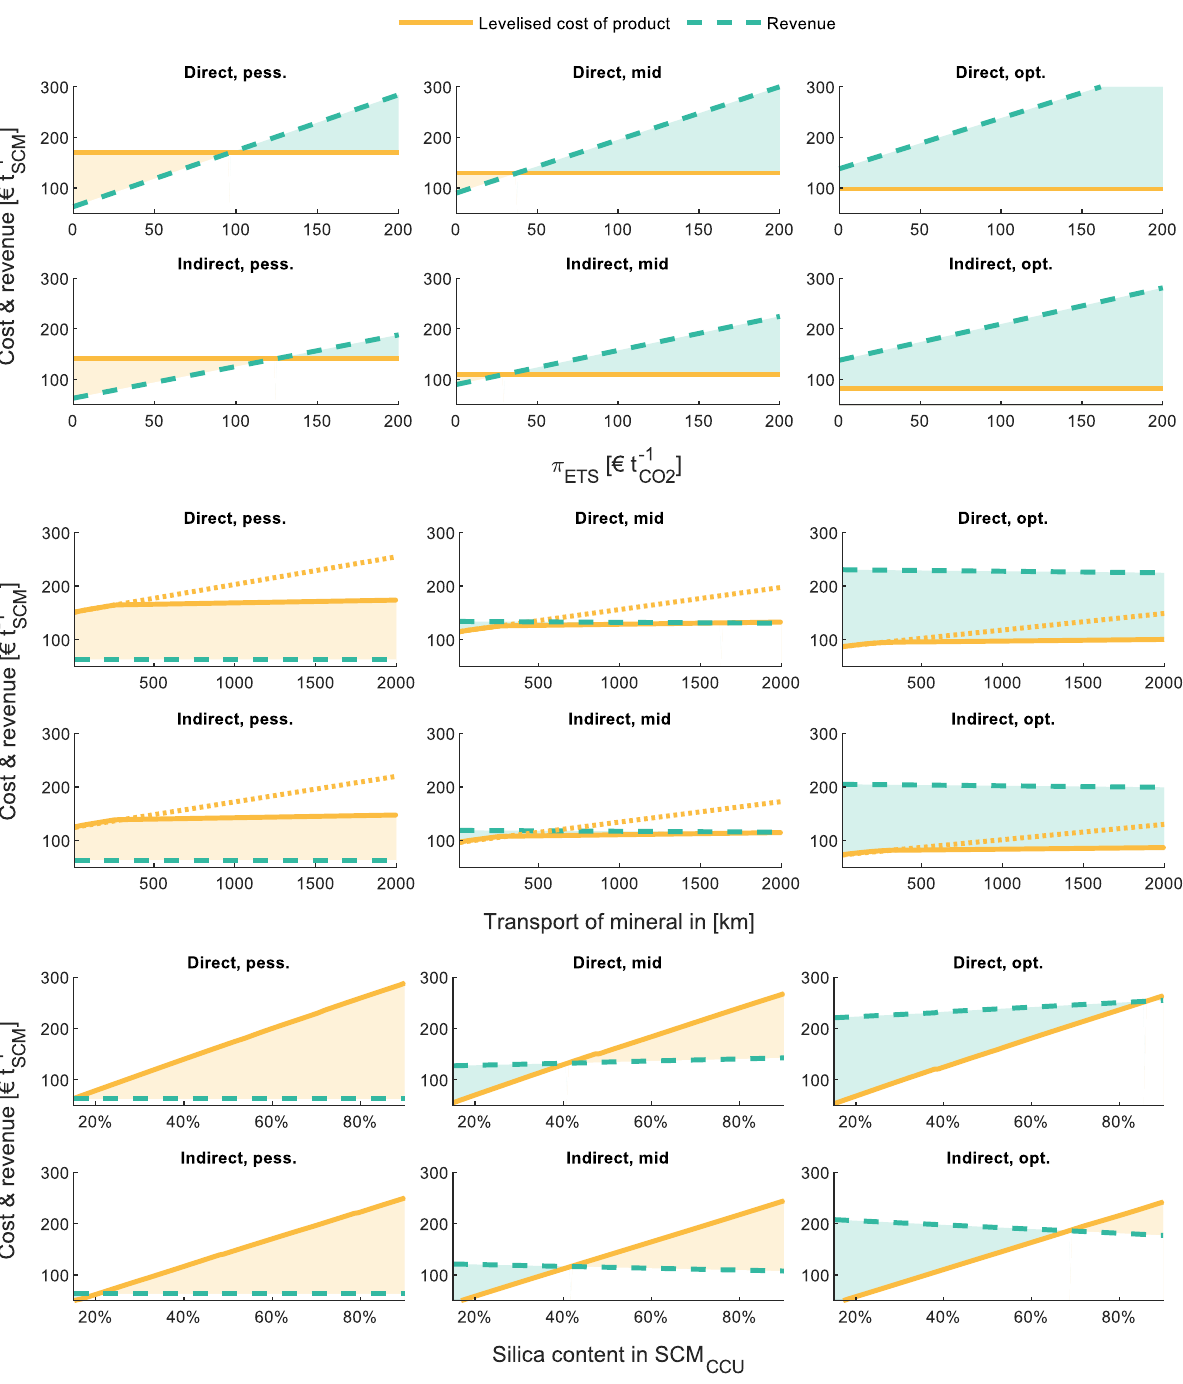
Fig. 3 Sensitivities of cost and revenues for different scenarios. a – c Comparison of levelised cost of product (beige solid line) and revenue (green dashed line), pro fi table areas marked in green, unpro fi table areas marked in beige. Assumptions for each scenario are maintained except for the parameter varied on the x-axis. As the capacities the optimal capacity for each scenario are assumed: pessimistic 136 kt SCM a − 1 , mid 272 kt SCM a − 1 , optimistic 340 kt SCM a − 1 (derived from Fig. 2a). a Effect of ETS price ( π ETS ). b Effect of transport distance of mineral feedstock – beige dotted line indicates the use of truck (max. 60 km) and train, solid line indicates the use of truck (max. 60 km), train (max. 200 km) and ship for transport. c Effect of silica content in SCM CCU